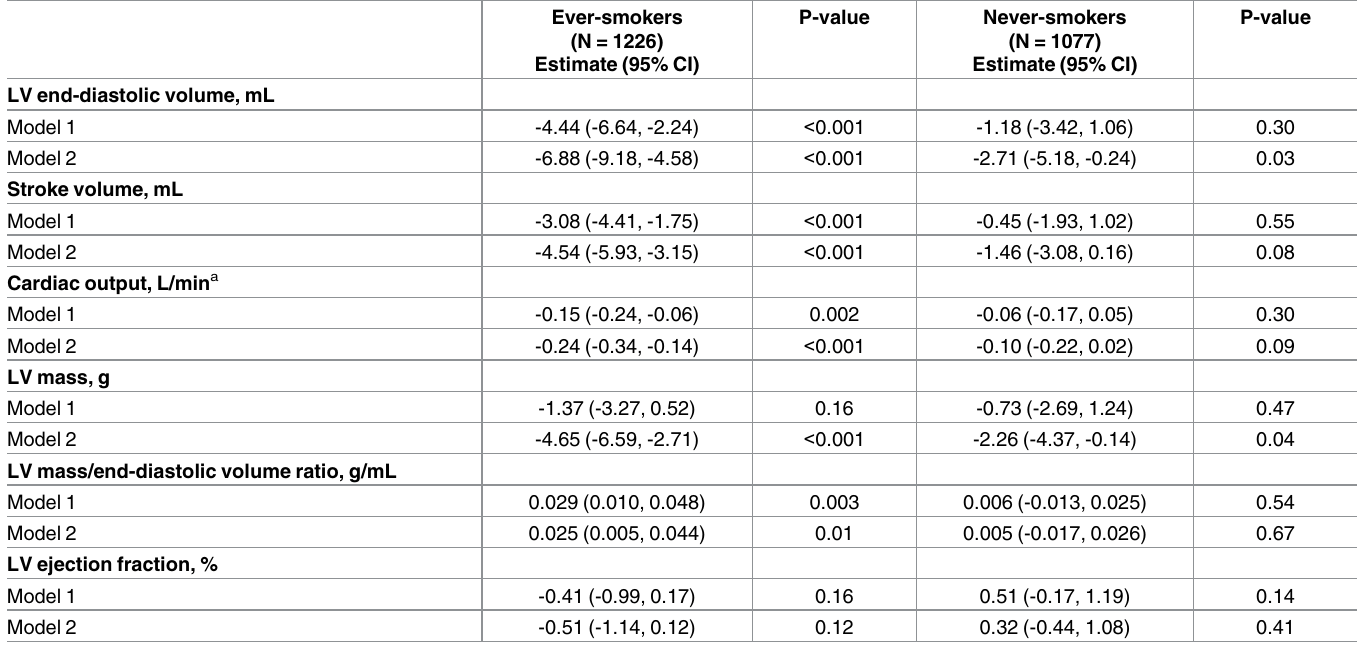
Table 2. Mean differences in LV parameters associated with a 1 SD lower total pulmonary vascularvolume, stratified by smoking status.